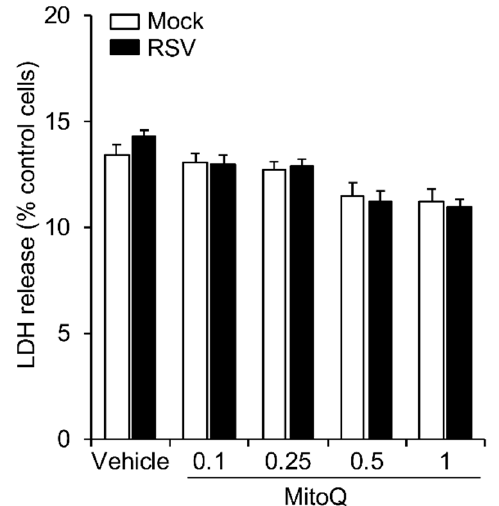
Figure A1. Lack of effect of MitoQ dose-response treatments on cell viability. A cytotoxicity detection kit (LDH Release Assay, Roche Applied Science) was used to analyse cell death on the basis of the amount of LDH (lactate dehydrogenase) released into the medium upon plasma membrane damage. A549 cells cultured in 96-well plates were infected with RSV (MOI 1, 24 h) with the addition of DMSO (vehicle) or MitoQ (0.1, 0.25, 0.5, and 1 µ M) for the last 16 h. The LDH assay was then carried out as previously [19,23]. Results represent the mean + SEM ( n = 3).